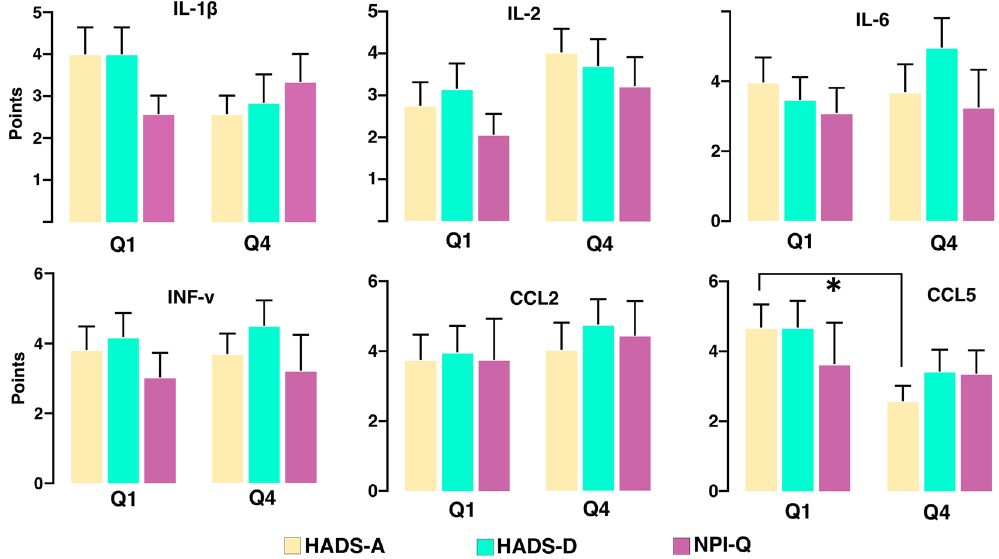
Figure 4. Difference of neuropsychological symptoms between upper and lower quartile of cytokines. We compared the baseline HADS-A, HADS-D, and NPI-Q severity score between lower (Q1) and upper